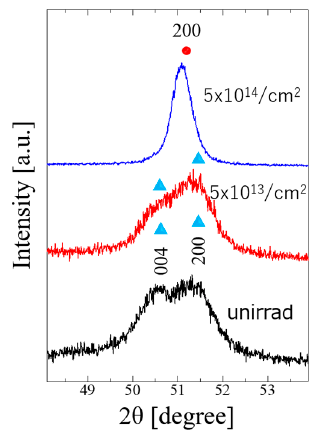
Figure 16. ( a ) Phase diagram of Ni-V binary alloy near the V concentration of 25% and ( b ) crystal structures of D0 22 (tetragonal) and A1 (fcc).